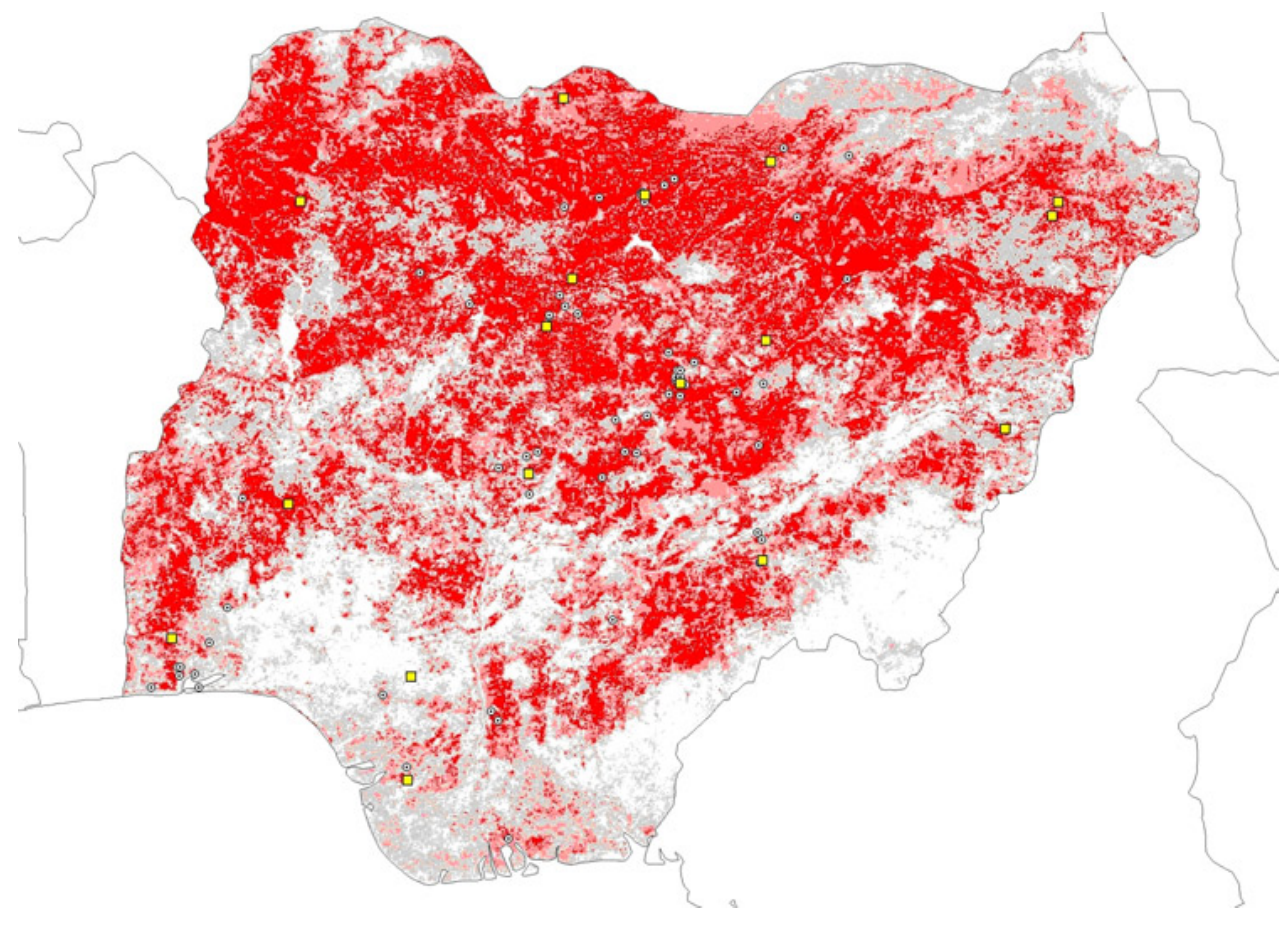
Fig. 2. Example prediction of HP-H5N1 occurrences in poultry in Nigeria (Williams et al. 2008). Dotted circles indicate 72 occurrences in January-November 2006 that were used to train the model. Model predictions are summarized as a ramp of colors, ranging from white (all replicate models agreed in predicting absence) to red (all replicate models agreed in predicting potential for presence). Yellow squares indicate independent occurrences from November 2006-January 2007 that were used to test the model predictions. Note the close correspondence between the spatial position of these occurrences and the red areas, which was statistically significantly better than